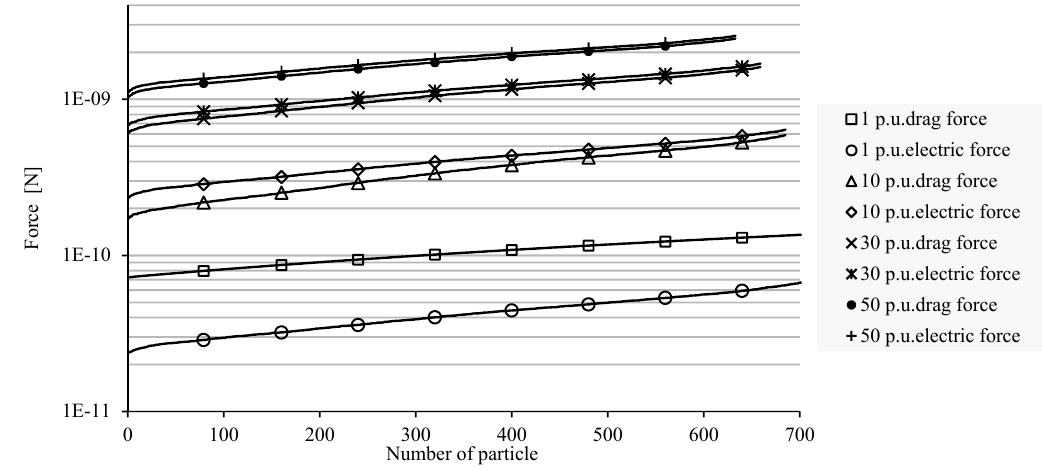
Figure 8. The curves of drag force and electric field force on the particles with different Q.